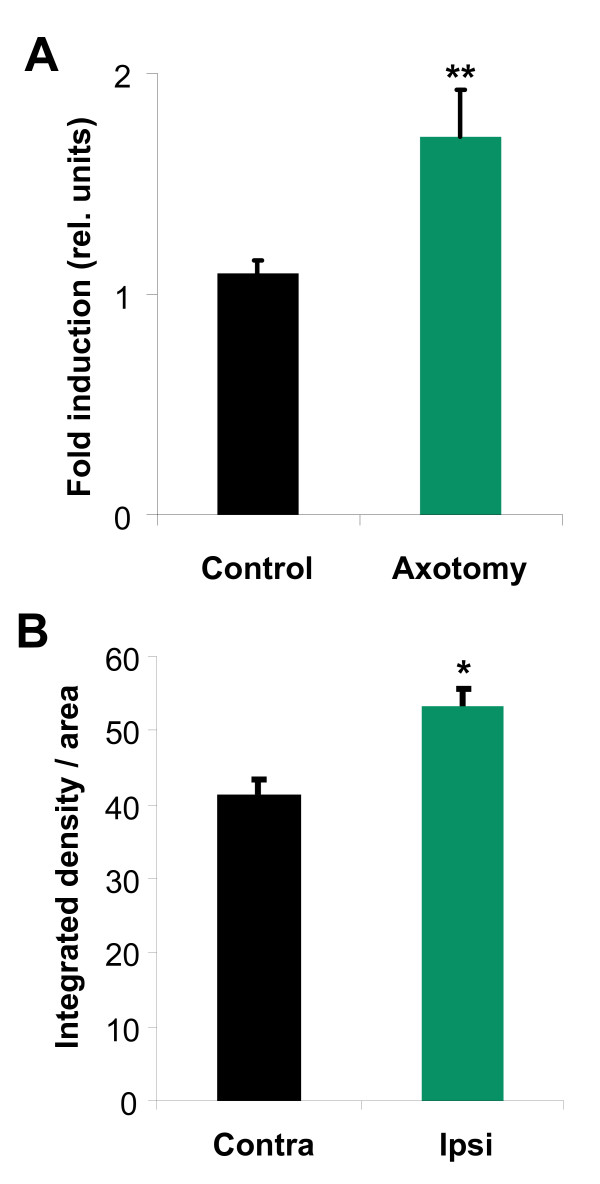
G-CSF receptor expression after sciatic nerve axotomy. (A) G-CSF receptor is upregulated after sciatic nerve axotomy in spinal cord of neonatal mice. Quantitative PCR for G-CSF receptor of spinal cords of axotomized or not neonatal mice (induction of 55%; n = 3, **p < 0.005). (B) G-CSF receptor staining intensity is stronger on the motoneurons after axotomy. Fluorescent intensity of G-CSF receptor staining on motoneurons was calculated on the ipsi- and contralateral side with an image processing program (*p < 0.05, n = 49).